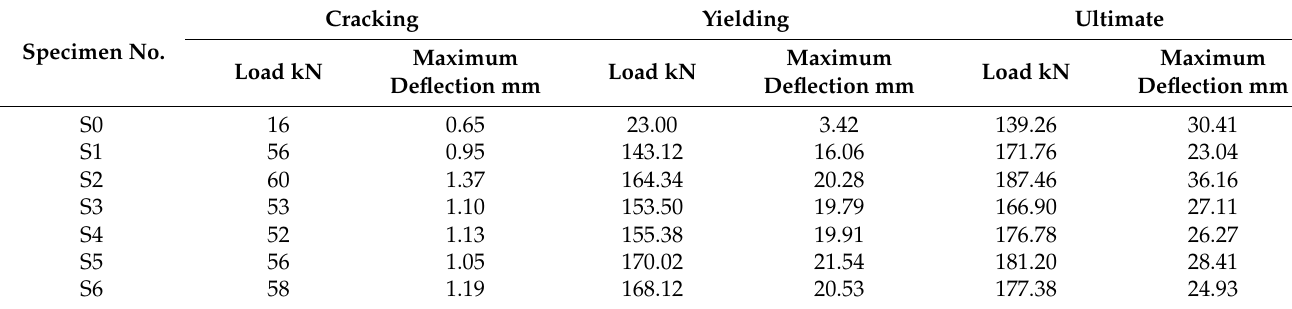
Table 3. FE results of beam specimens.